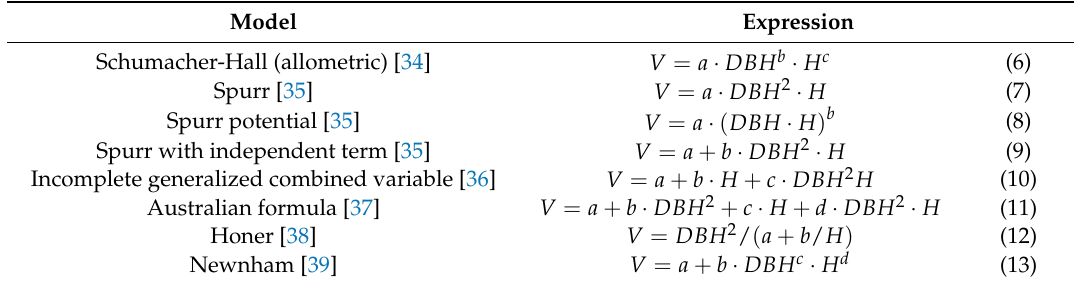
Table 2. Models tested for fitting volume equations to diameter at breast height (DBH, cm) and total tree height (H, m) data of teak trees in the